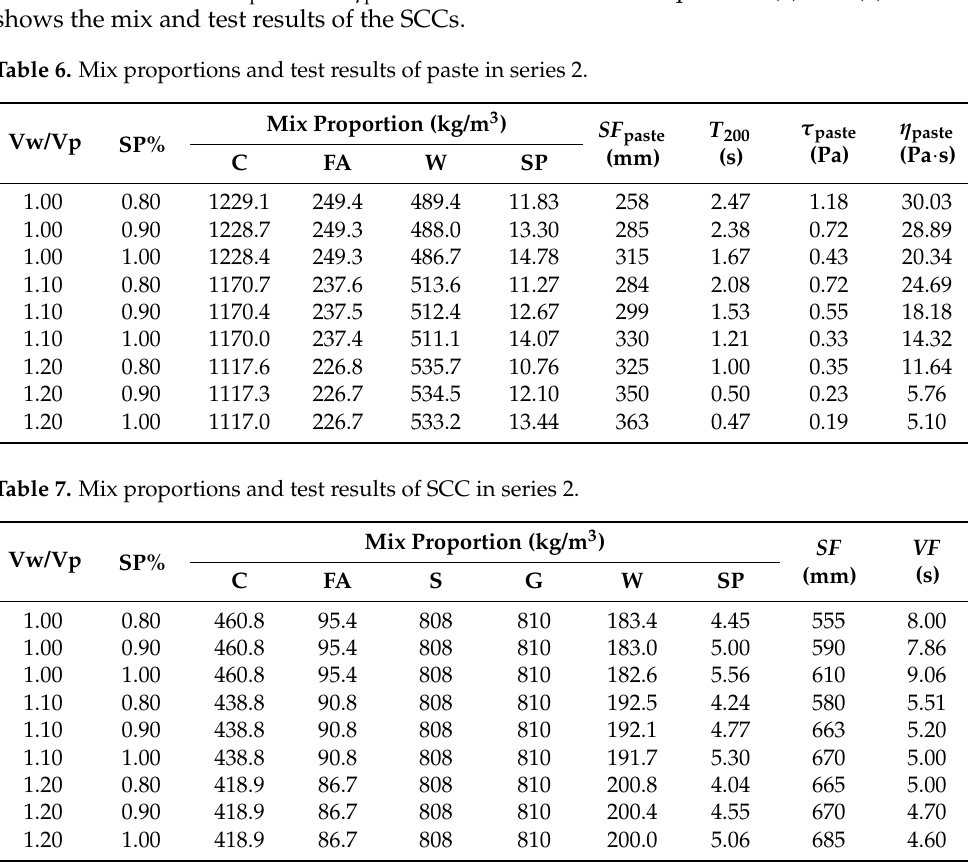
Series 2 contains binary powder, cement and FA. The substitution rate of FA was 20%